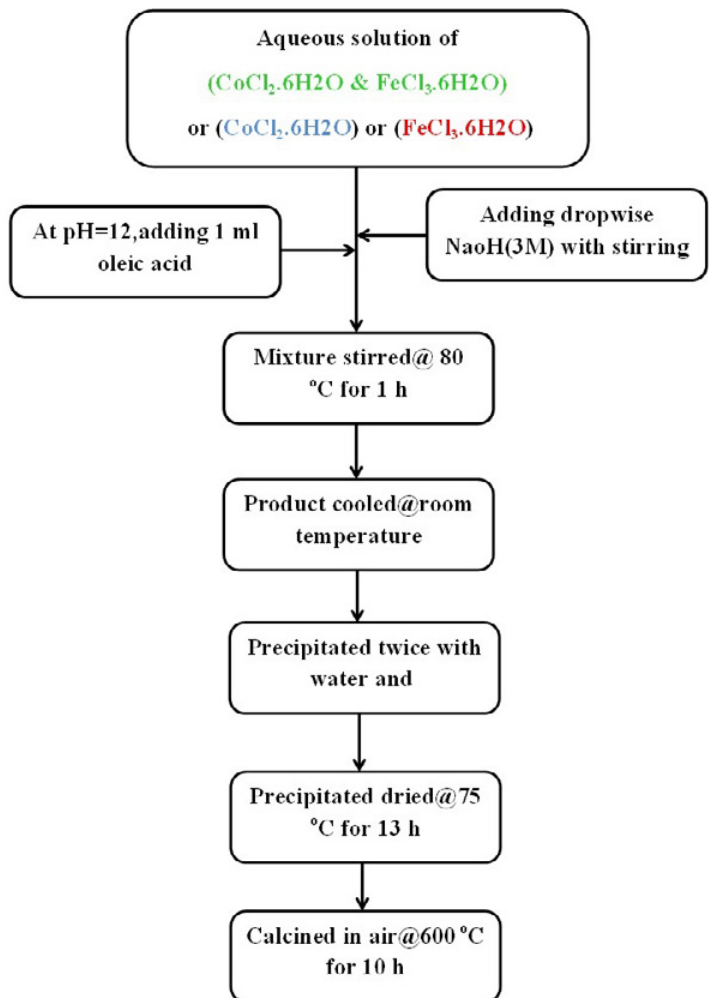
Fig. 1. Flow chart for wet chemical route preparation of cobalt ferrite nanocomposite, cobalt oxide and iron oxide